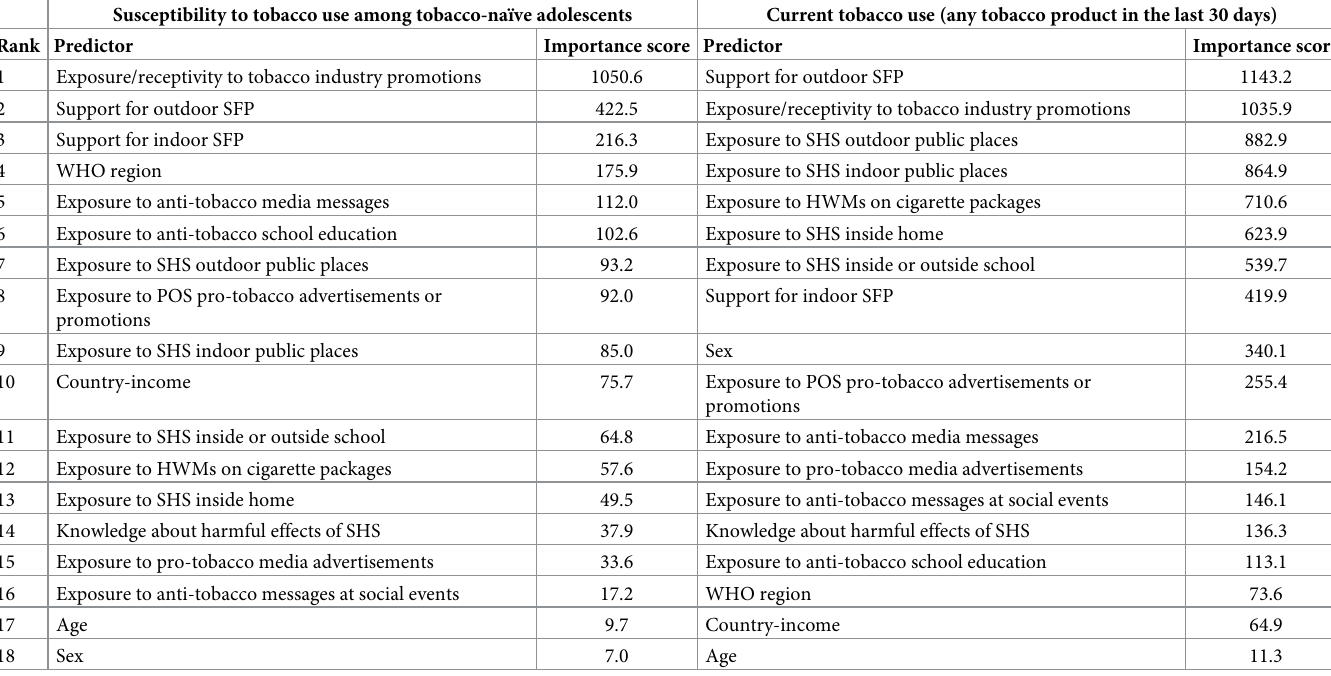
Table 3. Ranking of regression tree predictors of tobacco susceptibility and use by importance